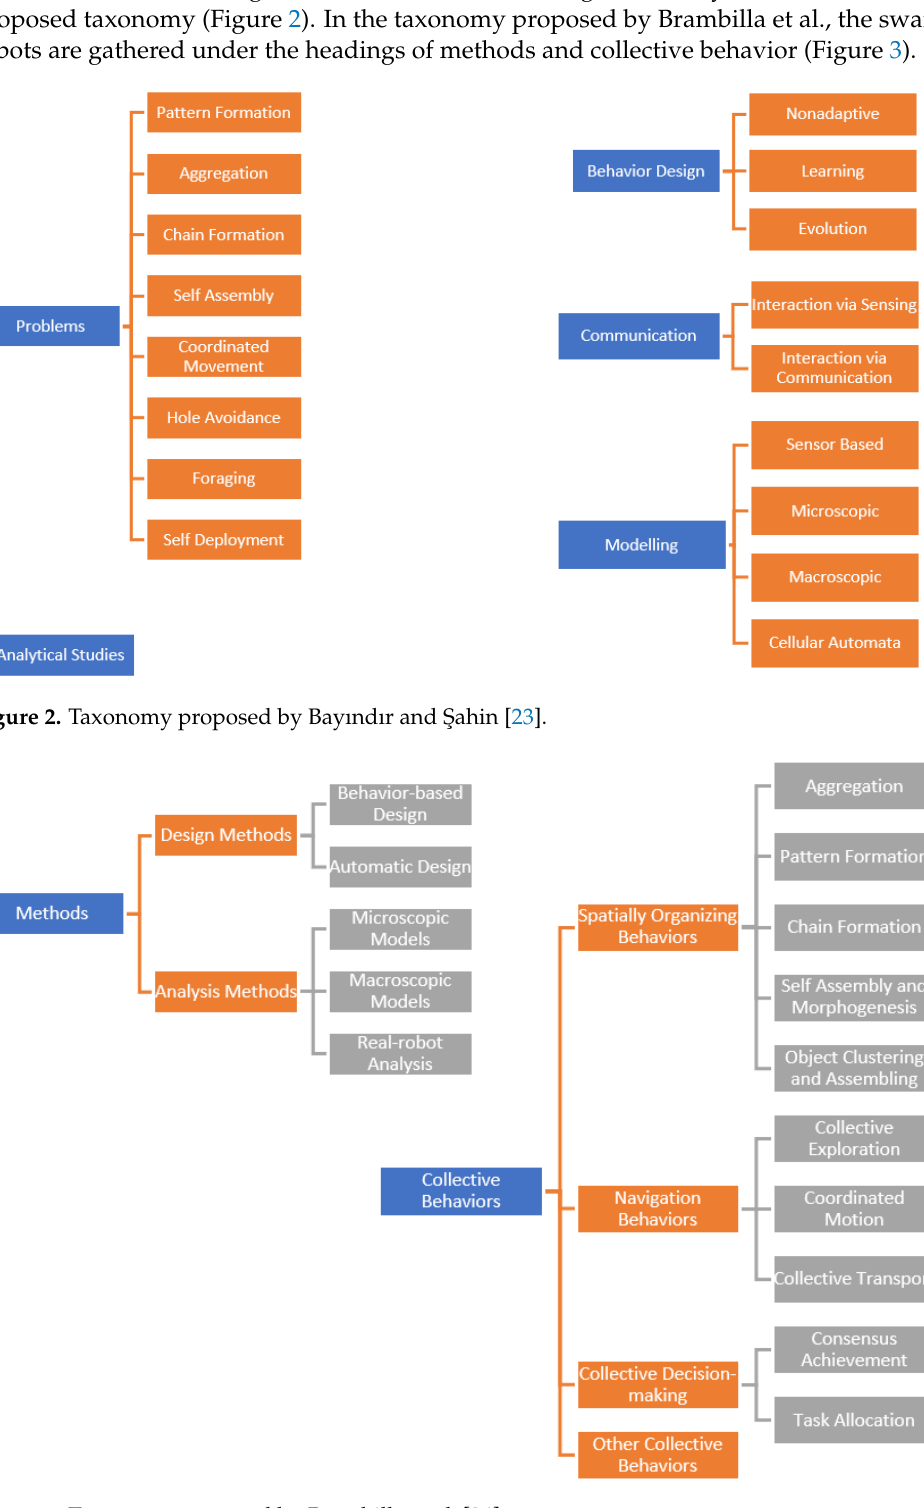
Figure 3. Taxonomy proposed by Brambilla et al. [24].